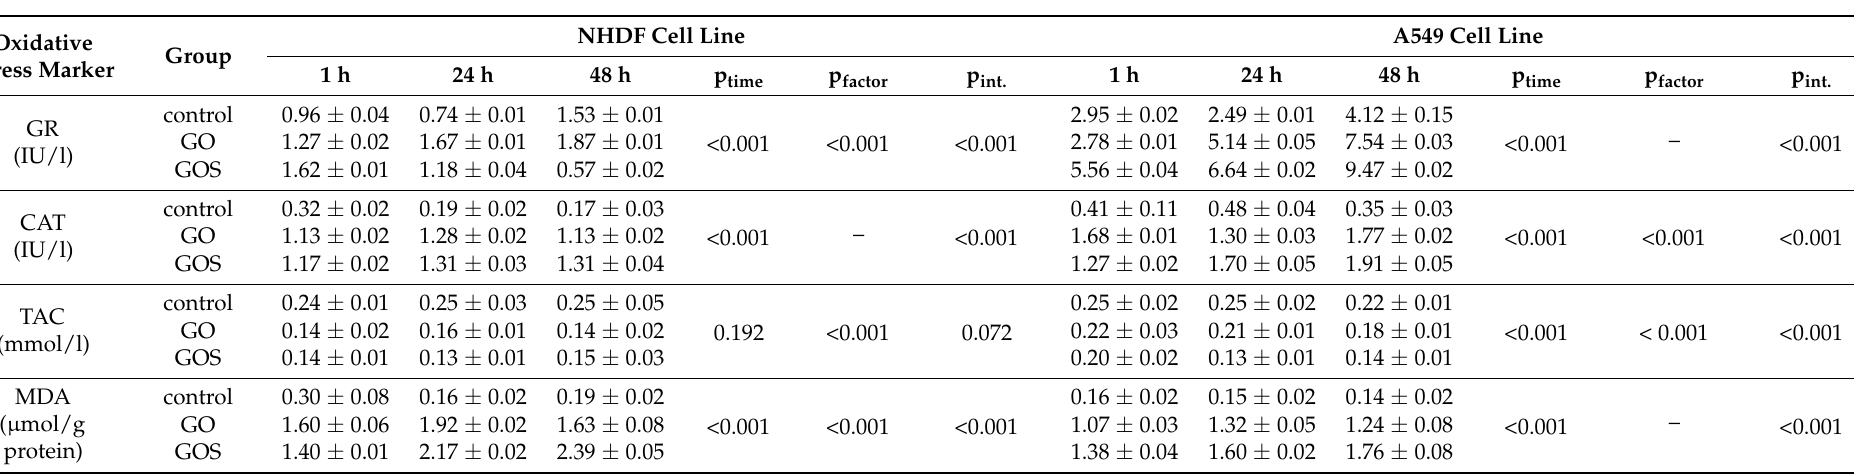
Table 1. Oxidative stress markers’ levels in NHDF (normal human dermal fibroblasts) and A549 (adenocarcinomic human alveolar basal epithelial cells) cell line measured 1, 24, and 48 h after exposure to ultrapure (GO) or manganese ions-contaminated graphene oxide (GOS). Categorical factors: time (time passed from exposition to GO/GOS to samples’ collection), factor (GO or GOS vs. control group); int. (interaction between time and type of factor (GO vs. GOS)). The results are presented as mean ± standard deviation. Statistical significance was set at a p <